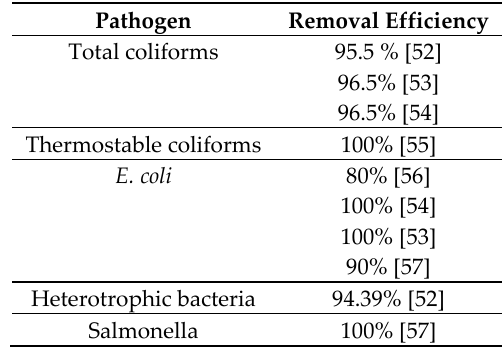
Table 6. Pathogen removal efficiency for rainwater first-flush systems.